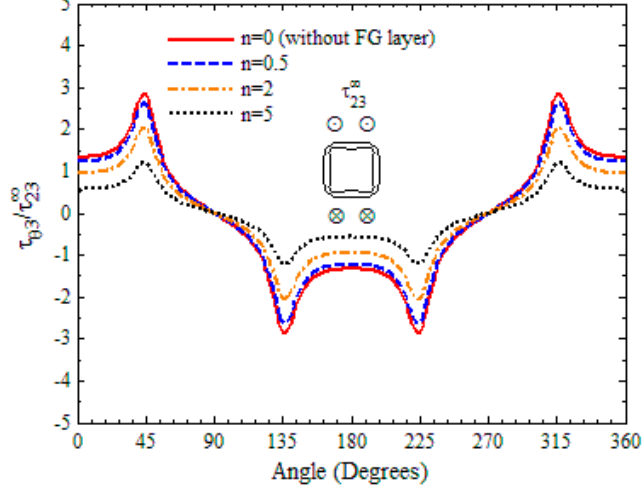
Figure 6. The variation in shear stress